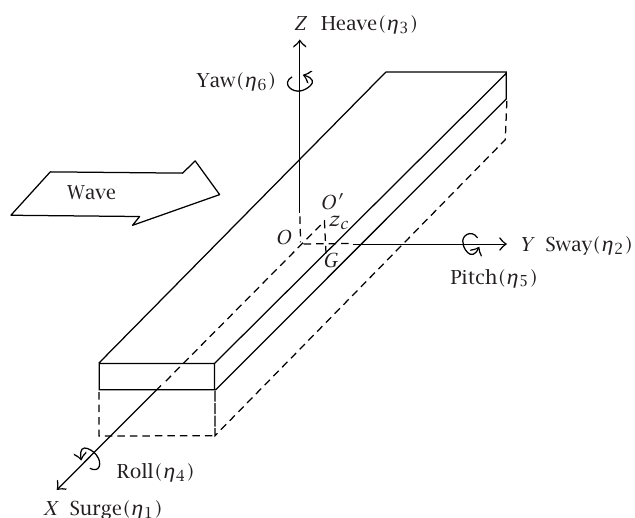
Figure 1.1 . Sign convention for translatory and angular displacements of a floating body with the direction of wave